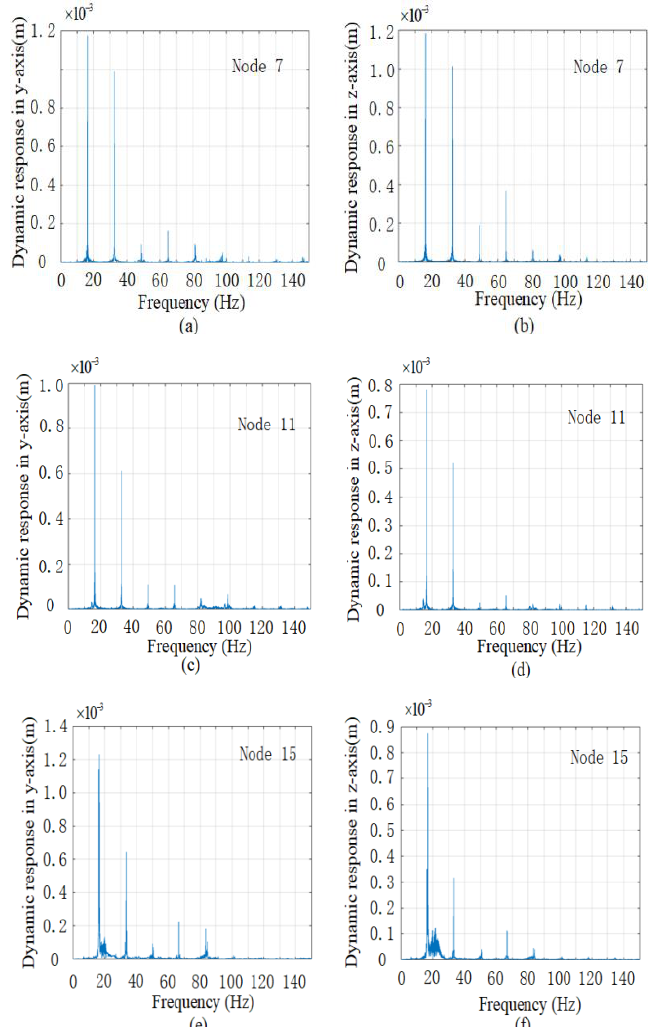
Figure 19. The experimental dynamic response with 0.8 mm parallel misalignment and 0.5 ◦ angular misalignment of nodes 7, 11, and 15 in the y-axis and z-axis. ( a ) Node 7 in the y-axis. ( b ) Node 7 in the z-axis. ( c ) Node 11 in the y-axis. ( d ) Node 11 in the y-axis. ( e ) Node 15 in the y-axis. ( f ) Node 15 in the z-axis.